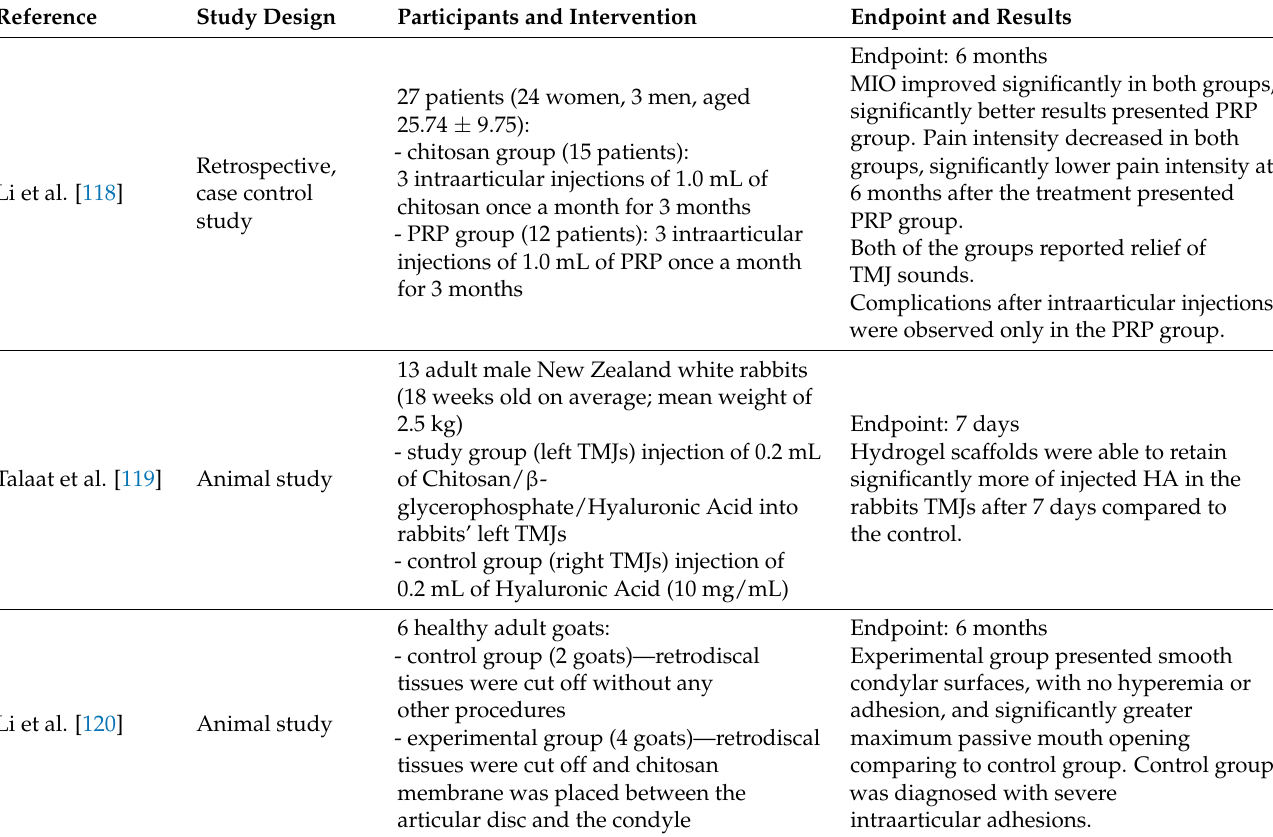
Table 3. Effectiveness of chitosan used in the treatment of the TMD from the in vivo studies